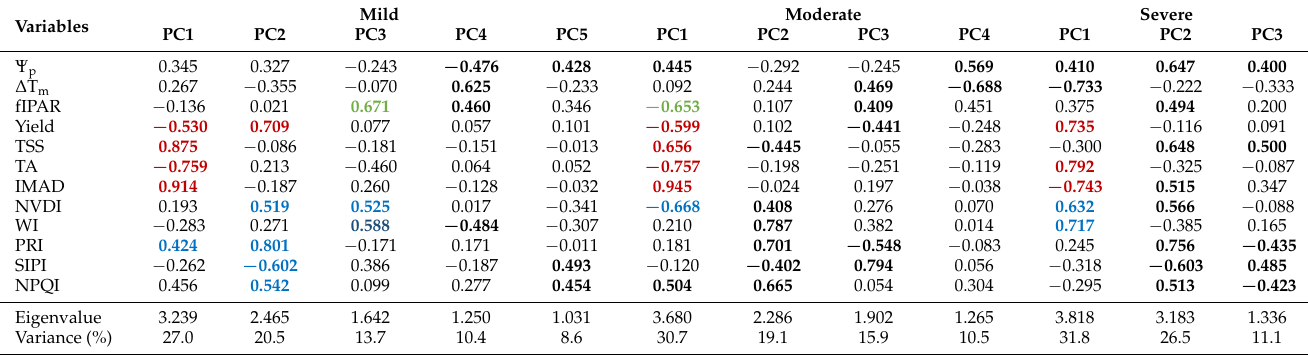
Table 7. Eigenvectors for vine vigour (fractional intercepted PAR, fIPAR), water status variables (predawn water potential, Ψ p ; and canopy to air temperature difference, ∆ T m ), berry yield and quality attributes (Total Soluble Solids, TSS; total titratable acidity, TA; and maturation index, IMAD) and reflectance indices (Normalized Difference Vegetation Index, NDVI; Water Index, WI; Photochemical Reflectance Index, PRI; Structural Independent Pigment Index, SIPI; and Normalized Phaeophytiniza- tion Index, NPQI). Principal Component Analysis results are shown for separate sets considering the intensity of water deficits: mild ( Ψ p > − 0.4 MPa), moderate ( − 0.4 MPa < Ψ p < − 0.8 MPa) and severe ( Ψ p < − 0.8 MPa). Sample size is n = 24, n = 22 and n = 55 for mild, moderate and severe water deficits, respectively. Bold characters indicate variables with large factor loadings. Vine biophysical attributes are highlighted in green, berry yield and quality attributes in red and reflectance indices in